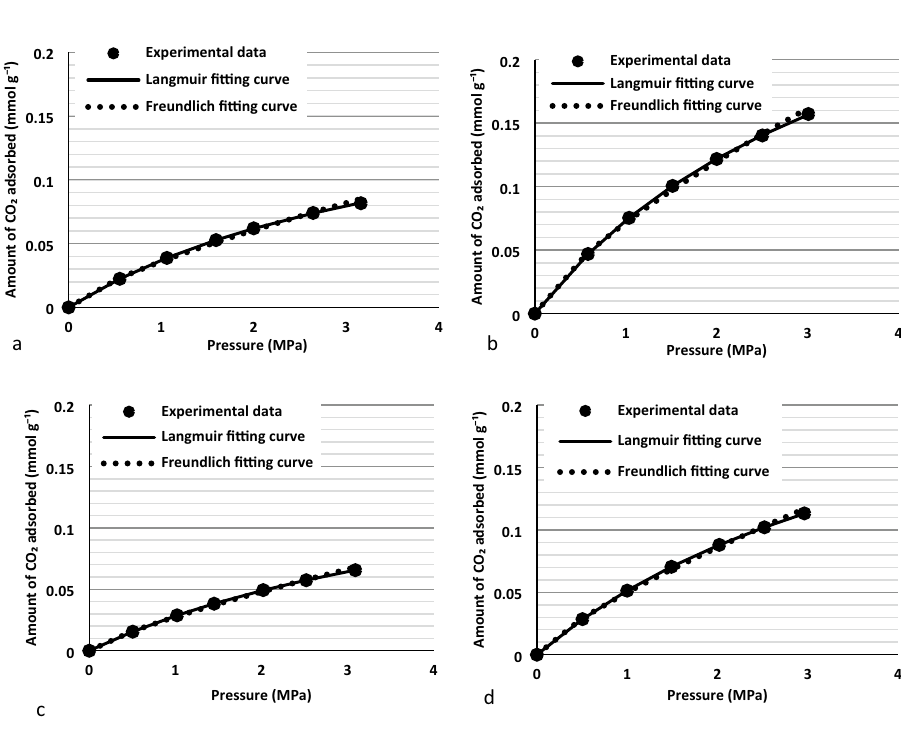
Fig. 9 Comparison of differ- ent CO 2 adsorption experiment and isotherm fitting curve from WB coal samples with various conditions: a powder samples under raw condition, b powder samples under dry condition, c block samples under raw condi- tion, and d block samples